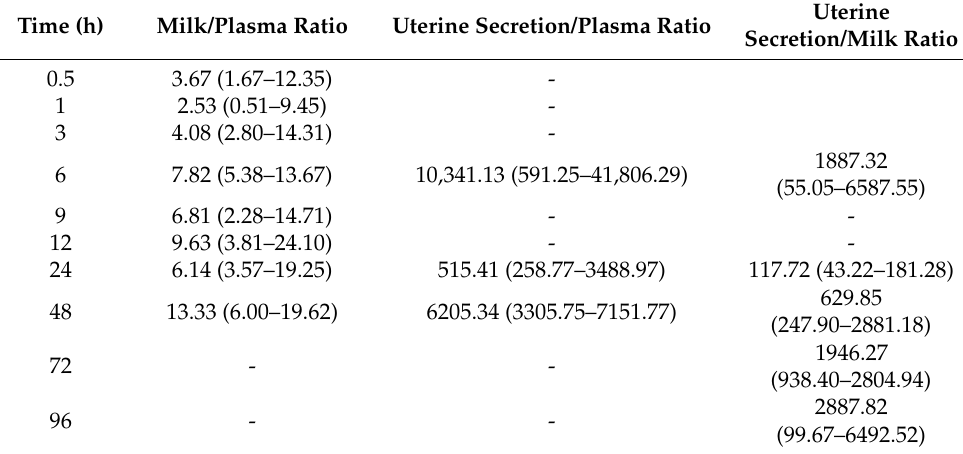
Table 4. Milk/plasma ratio, uterine secretion/plasma ratio and uterine secretion/milk ratio (median and range min–max) of oxytetracycline concentrations in cows ( n = 6) with clinical metritis after the intrauterine administration of 8 mg/kg of 10% solution of oxytetracycline for three consecutive